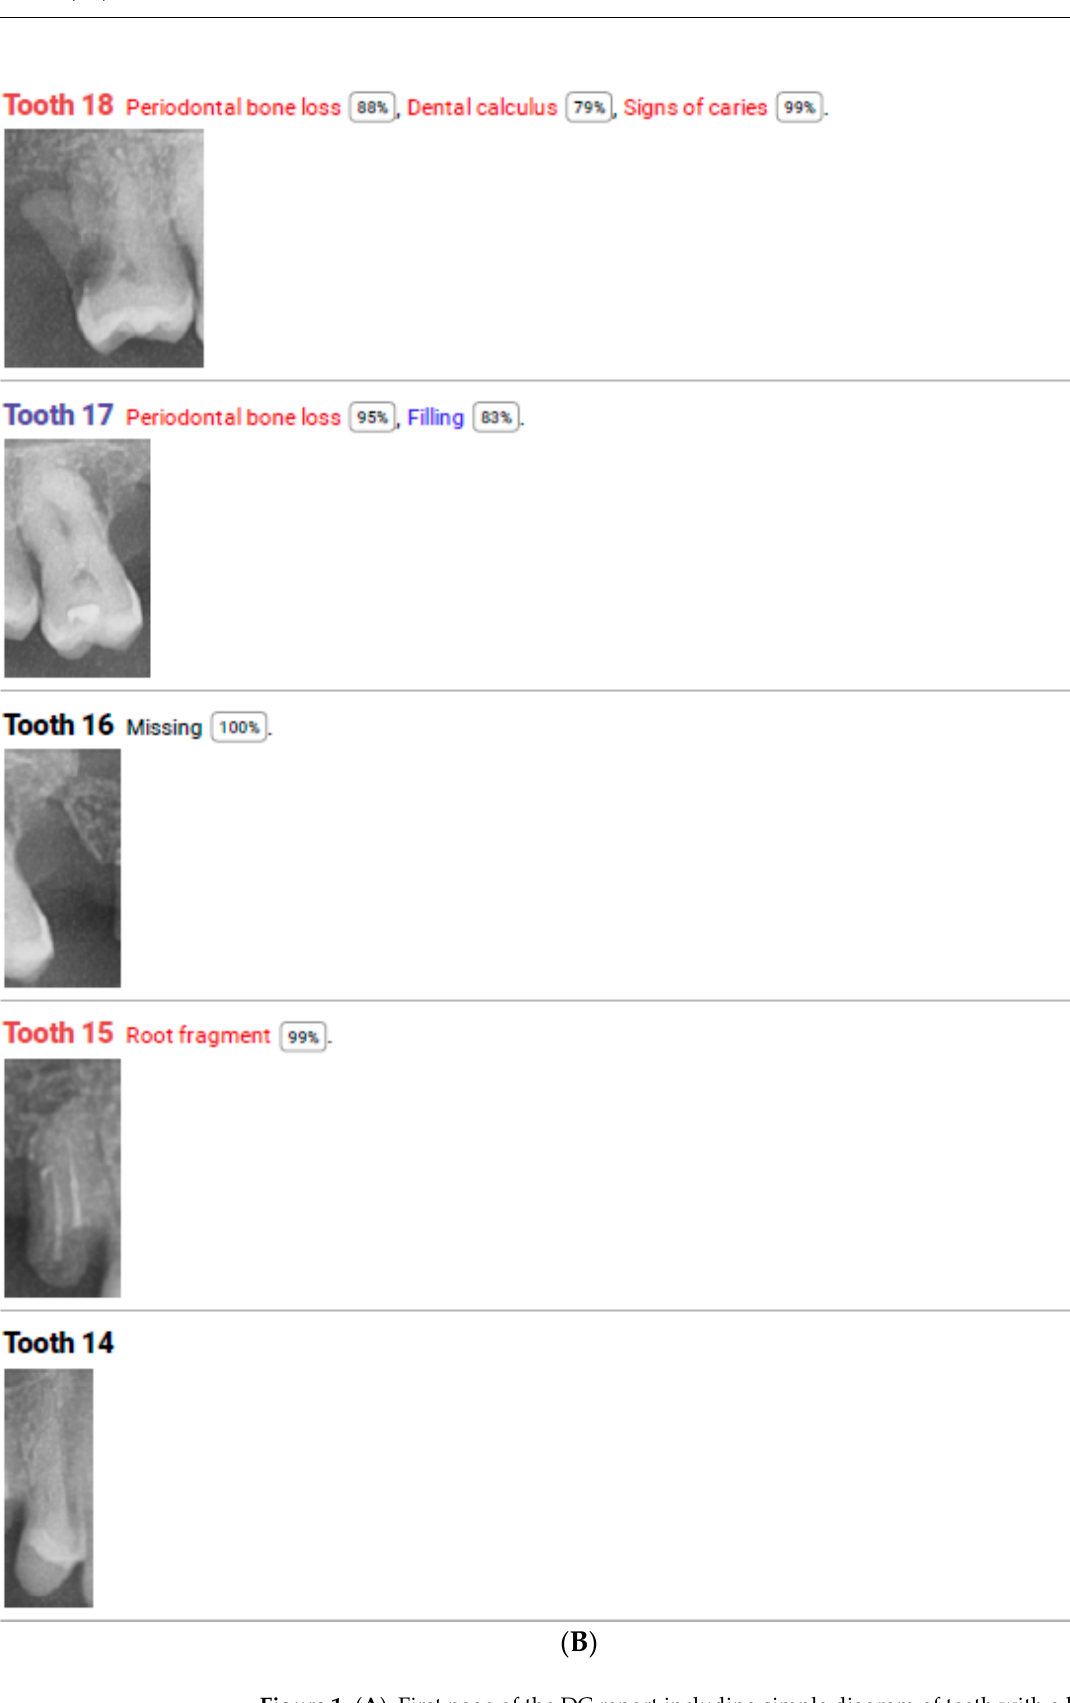
Figure 1. ( A ). First page of the DC report including simple diagram of teeth with a legend of findings and referral recommendations pointing specific specialists for specific teeth. ( B ). One of the following pages of the DC report including specific teeth captions and description with percent of